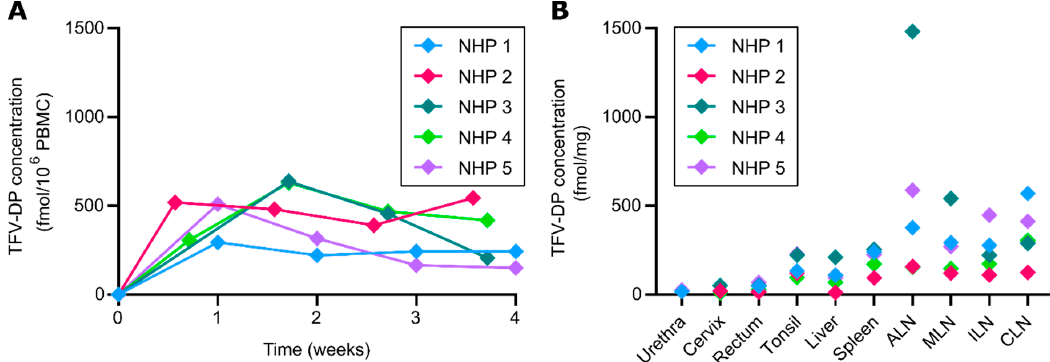
Figure 2. Tenofovir-diphosphate (TFV-DP) peripheral blood mononuclear cells (PBMC) and tissue distribution of TAF from subcutaneous nTAF t . nTAF t implants ( n = 5) were retrieved after 1 month. ( A ) Intracellular TFV-DP PBMC concentrations of nTAF t . ( B ) Tissue TFV-DP concentrations upon euthanasia after 1 month of implantation. NHP, nonhuman primate, ALN, axillary lymph nodes, MLN, mesenteric lymph nodes, ILN, inguinal lymph nodes, CLN, cervical lymph nodes.